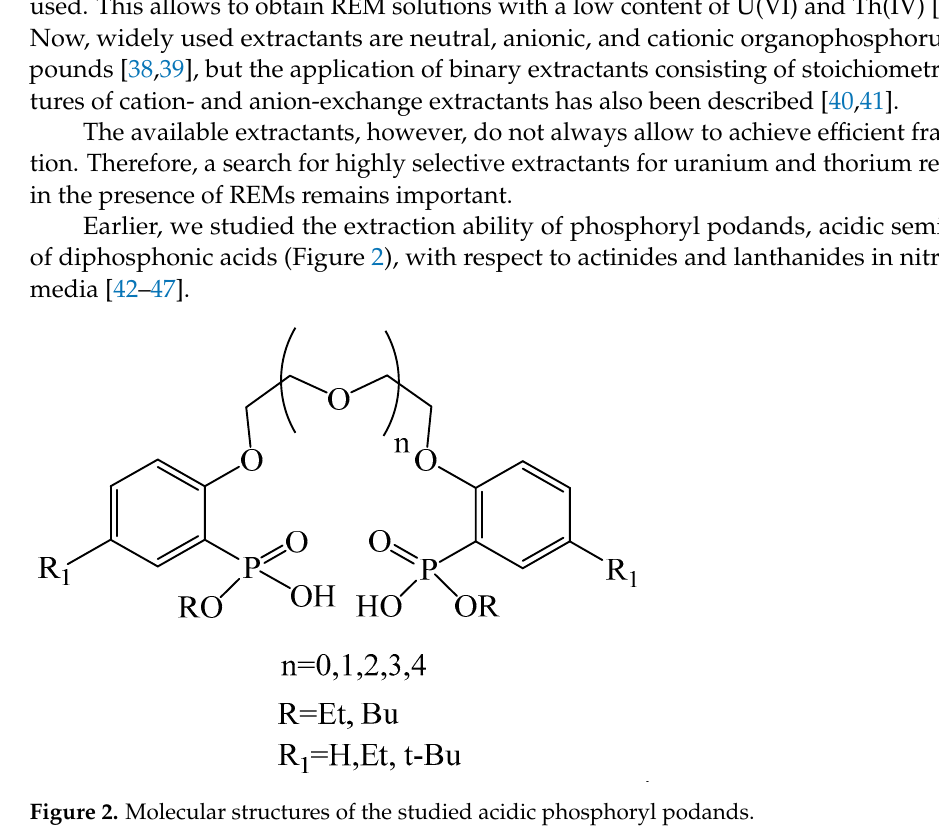
Figure 2. Molecular structures of the studied acidic phosphoryl podands.